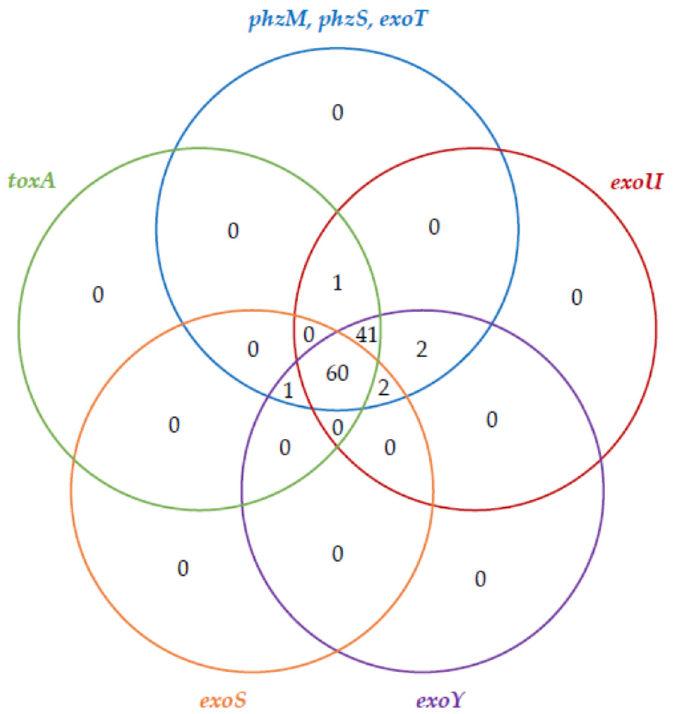
Figure 2. The co-existence of toxin synthesis-associated genes (Venn diagram) amongst the examined P. aeruginosa strains ( n = 107).